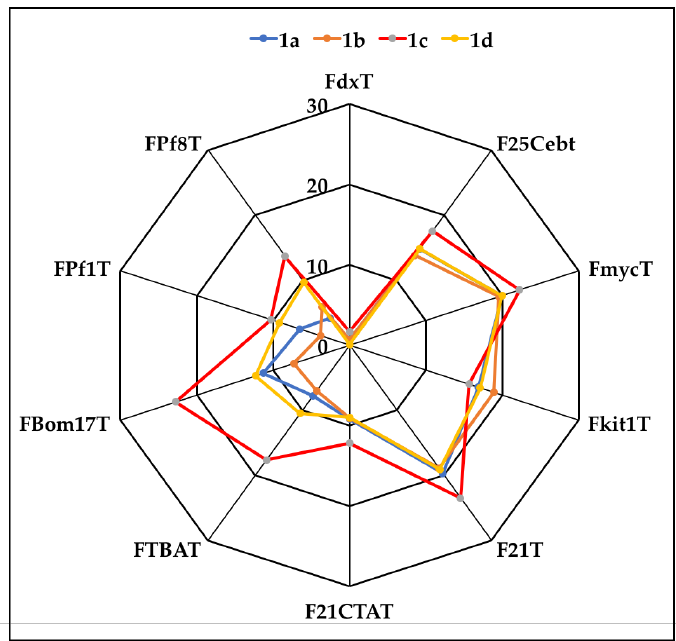
Figure 3. Stabilization specificity profile of 1a – d (5 µM) toward various G4 oligonucleotides. The difference in T m in presence and absence of 1a – d , ∆T m , in °C is plotted for each sequence. 9 quadruplexes and one duplex (FdxT) were tested. Experiments were performed in 10 mM lithium cacodylate buffer (pH 7.2), 90 mM LiCl, and 10 mM KCl. T m in absence of ligands: FdxT (T m = 66.6 ± 0.7 °C), F25cebT (T m = 68.3 ± 0.7 °C); FmycT (T m = 64.8 ± 0.3 °C); Fkit1T (T m = 66.5 ± 0.3 °C ); F21T (T m = 52.4 ± 0.3 °C); F21ctaT (T m = 56.6 ± 0.2 °C); FtbaT (Tm = 46.1 ± 0.3 °C); Fbom17T (T m = 44.7 ± 0.6 °C); FPf1T (T m = 45.8 ± 0.9 °C); FPf8T (T m = 45.7 ± 0.2 °C).